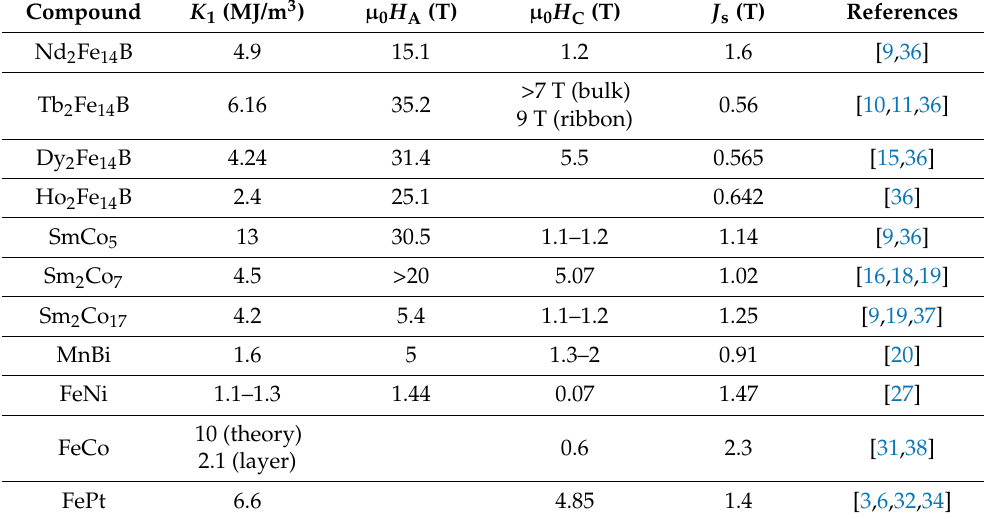
Table 1. Selected magnetic parameters ( K 1 is the anisotropy constant, H A is the anisotropy field, H c is the coercive field, and J s is the remanence polarization) for the high and ultra-high coercive phases. Compound K 1 (MJ/m 3